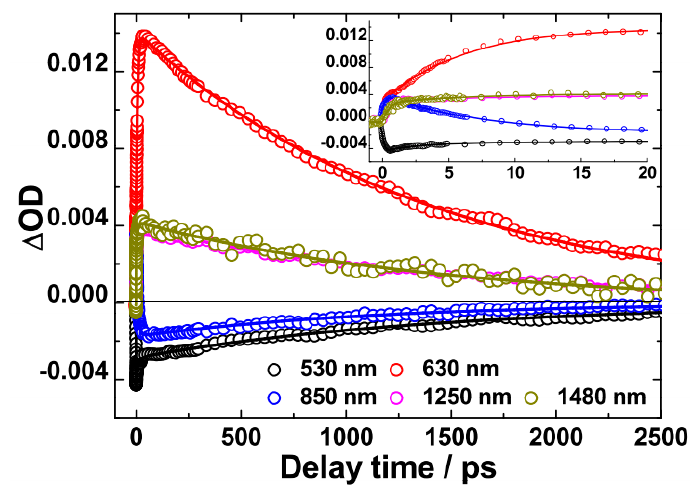
Figure 3. Kinetics at the indicated probing wavelengths plotted from the corresponding spectral dynamic in Figure 2 for PFDCN in chlorobenzene solution, Solid lines are fitting curves based on multi-exponential model functions.